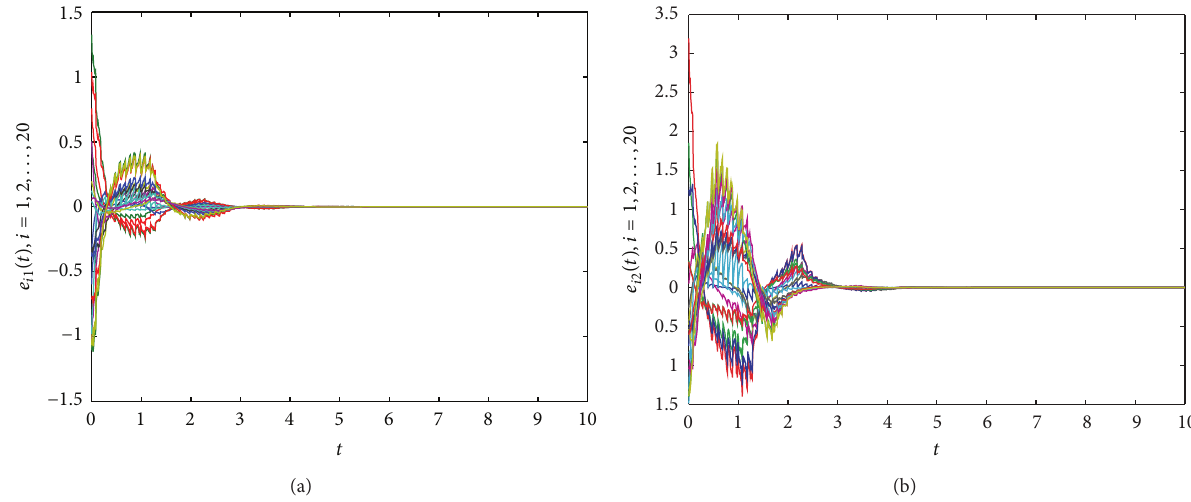
Figure 3: (a) The time evolution of 𝑒 𝑖1 ( 𝑖 = 1, 2,. .. ,10 ) in system (41) under pinning control. (b) The time evolution of 𝑒 𝑖2 ( 𝑖 = 1, 2, .. ., 10 ) in system (41) under pinning